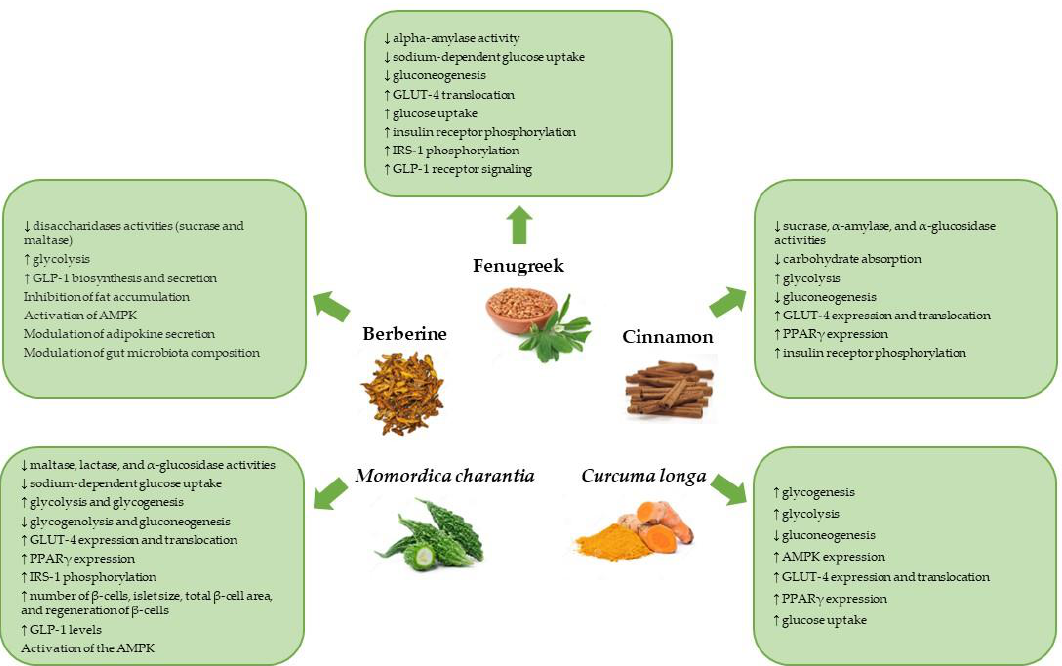
Figure 1. Mechanisms of action behind the hypoglycemic effects of fenugreek, cinnamon, Curcuma longa , berberine, and Momordica charantia . GLUT-4: glucose transporter 4, IRS-1: insulin receptor substrate 1, GLP-1: glucagon-like peptide-1, PPAR γ : peroxisome proliferator-activated receptor gamma, AMPK: adenosine monophosphate-activated protein kinase. ↑ : increase, ↓ : decrease.